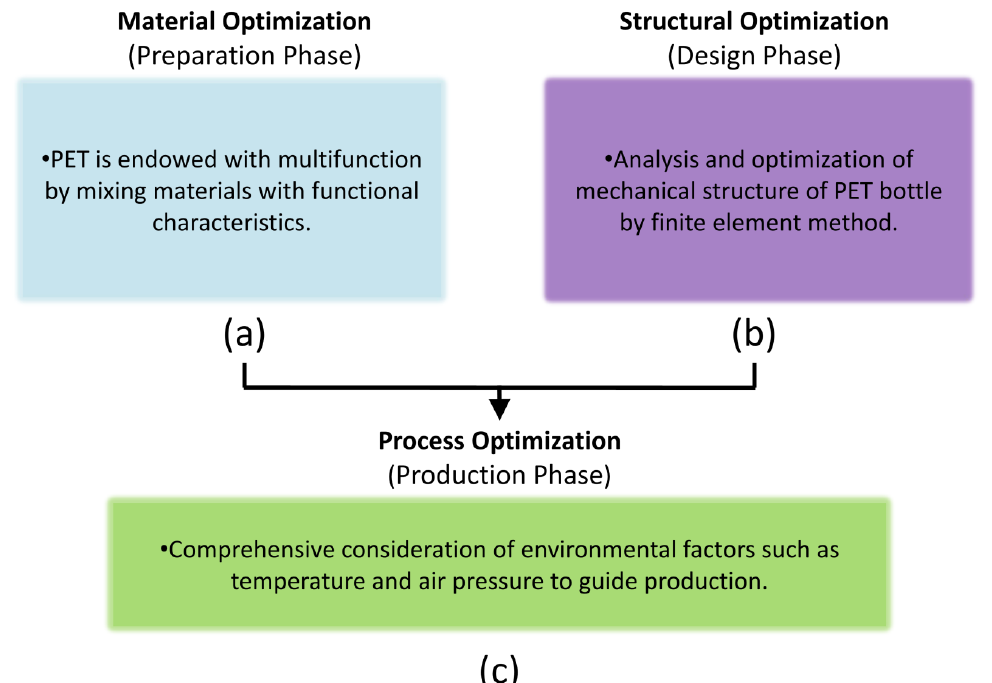
Figure 1. Three optimization methods of PET bottle.